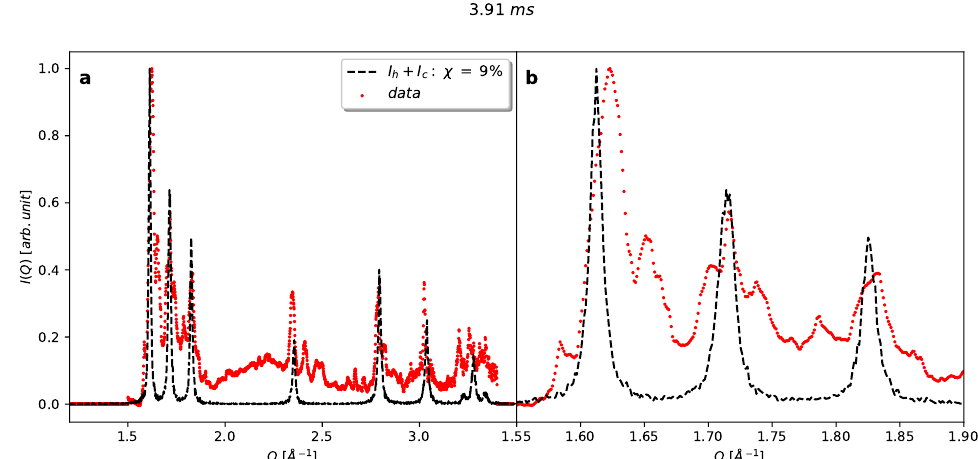
Figure A11. ( a ) Cubicity estimate for cubic and hexagonal mixture calculated from the peak heights of (002) and (101) of the hexagonal ice (black dashed) together with the corresponding experimental data at 3.91 ms travel time (red circles). ( b ) A zoom-in on the first three peaks of the model and